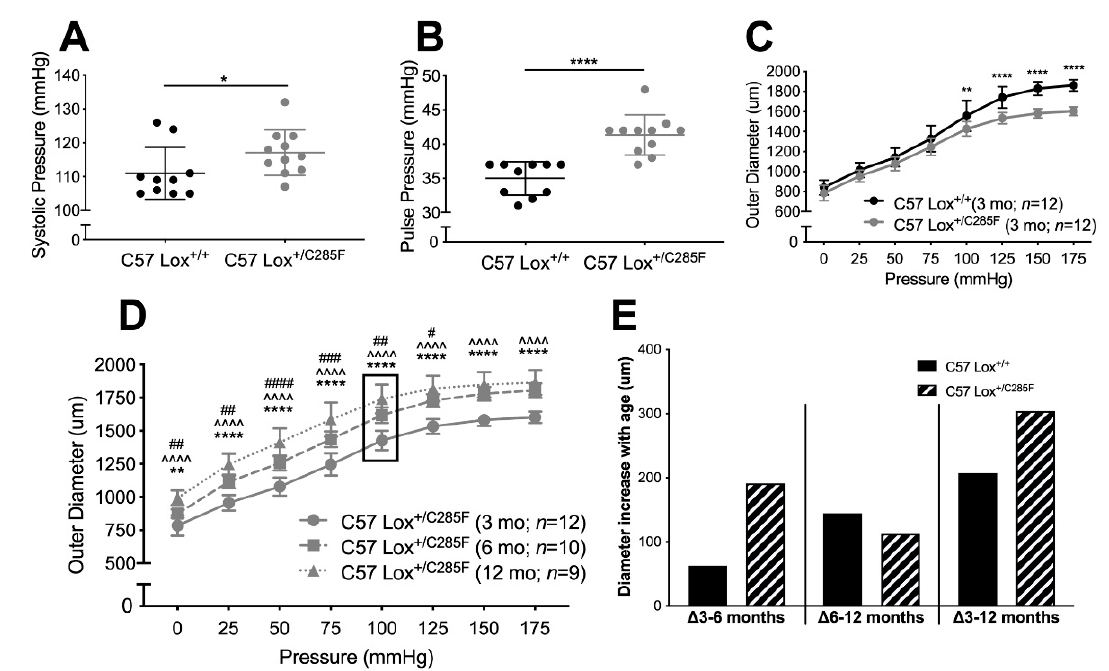
Figure 1. Mutation in Lox alters vascular mechanics. ( A,B ), SBP ( A ) and PP ( B ) are significantly higher in 3-month C57 Lox +/C285F mice (Mann–Whitney). ( C ), Aortic diameter is significantly smaller at pressures above 100 mmHg ( C , two-way ANOVA p < 0.0001 for genotype and pressure, multiple comparison testing by Sidak) but dilates with age (( D ), *—3 vs. 6 months, ^—3 vs. 12 months, and #—6 vs. 12 months; two-way ANOVA, Sidak). ( E ), Difference of average diameters over 3–6-, 6–12-, and 3–12-month intervals show a biphasic trajectory with the average C57 Lox +/C285F aorta dilating faster than C57 Lox +/+ early ( Δ 3–6 months) and leveling off later (( Δ 6–12 months), for larger change in diameter over the ∆ 3–12-month period. For all tests * , # p < 0.05, ** , ## p < 0.01, ### p < 0.001, and **** , ˆˆˆˆ , #### p <